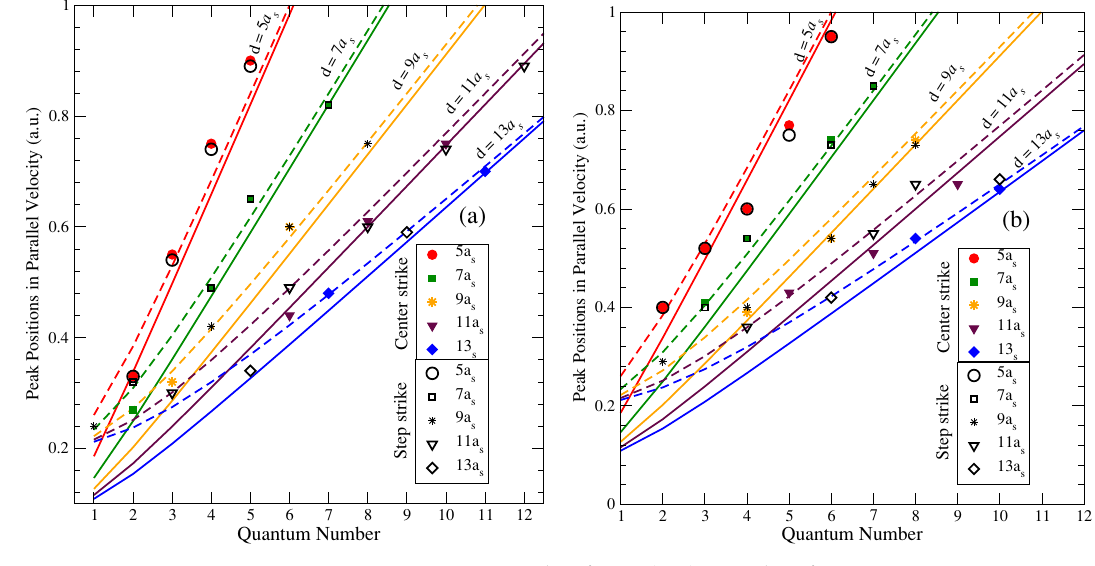
Figure 10. Same as Figure 9, but for Au(100) vicinal surface.